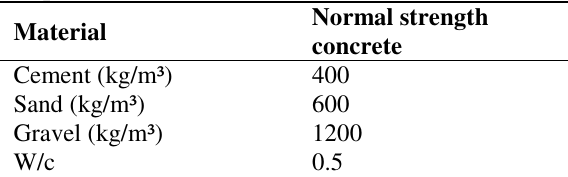
Proportions of Mix Per Cubic Meter